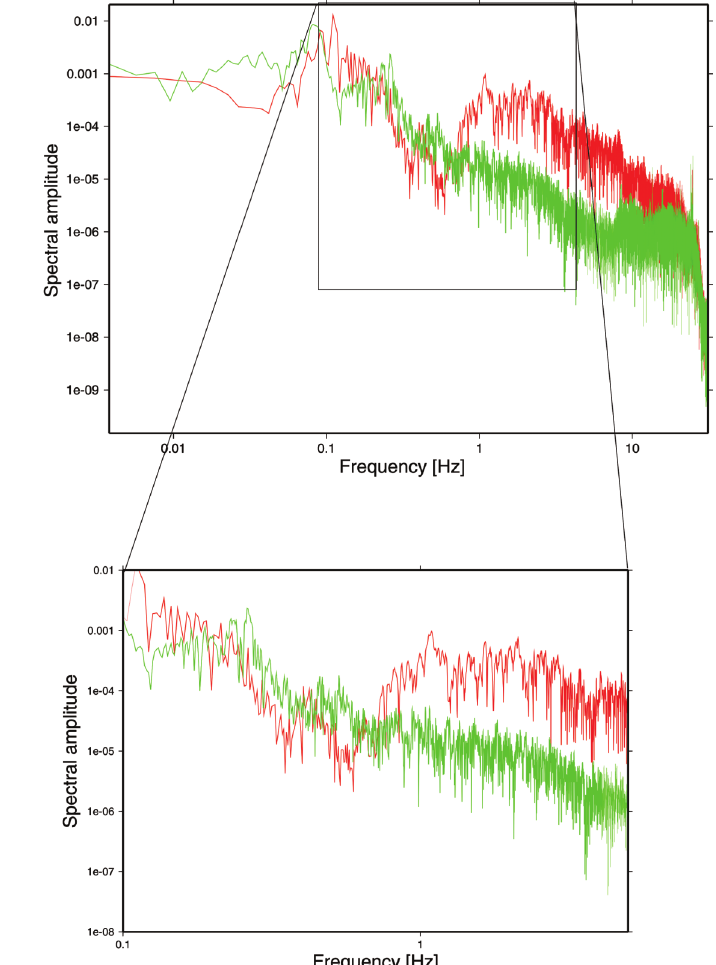
Fig. 10. Comparison of T wave spectrum (red line) and PS spectrum (green line) for GENL